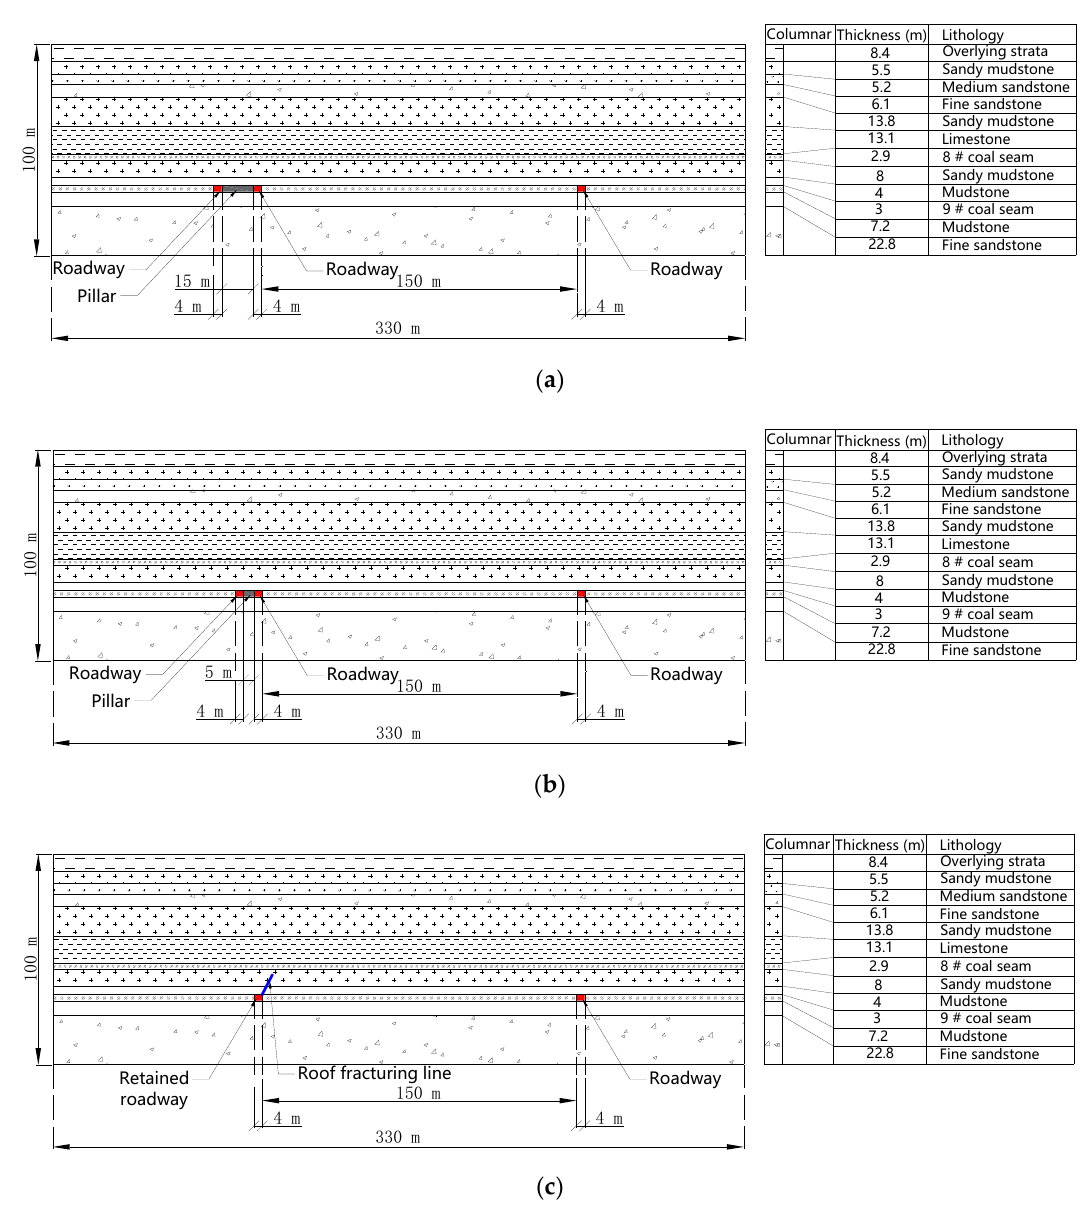
Figure 7. Geometry of the model. ( a ) Geometry of model of large pillar mining; ( b ) geometry of model of small pillar mining; ( c ) geometry of model of non-pillar mining.